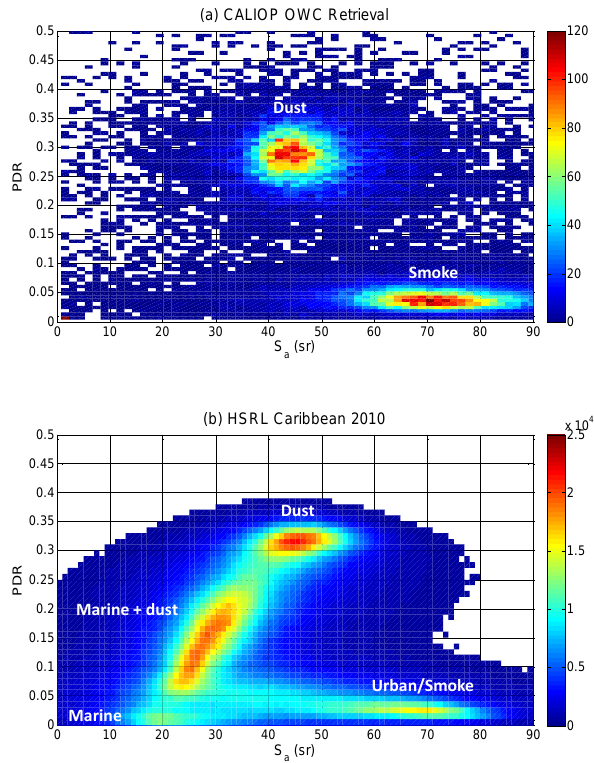
Figure 9. 2-D distributions of lidar ratio and PDR (a) retrieved us- ing the OWC constrained technique from six years of the CALIOP measurements and (b) measured by the NASA LaRC airborne HSRL during nine CALIOP validation flights during 11–28 Au- gust 2010 over the Caribbean Sea (see Burton et al., 2012 for more details about this validation campaign). Panel (a) is a composite plot made from the OWC constrained retrievals from the dust trans- port region (i.e., Fig. 8b) and from the smoke transport region (i.e., Fig. 10b, with the sample number being scaled by a factor of 1/3). Note that each CALIOP sample was obtained for a layer extending from cloud top to 8km, whereas each HSRL sample was measured for a 300m range bin.